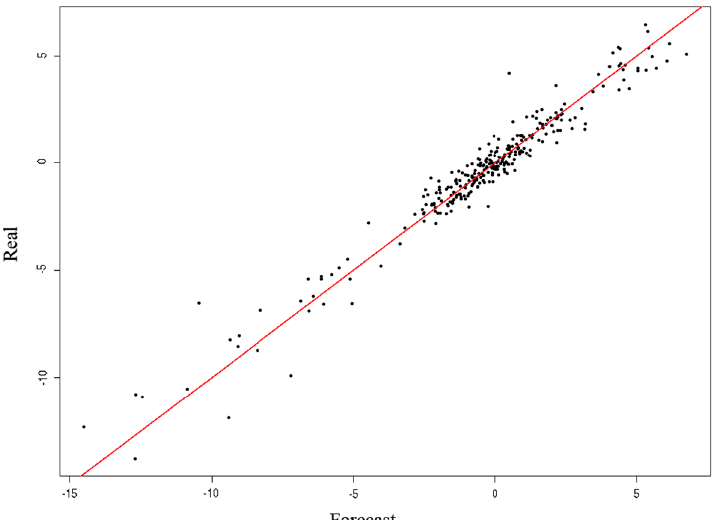
Fig. 6 Goodness of fit of the model designed, described by the covariant of the series cumulative number COVID deaths. Source : Authors’